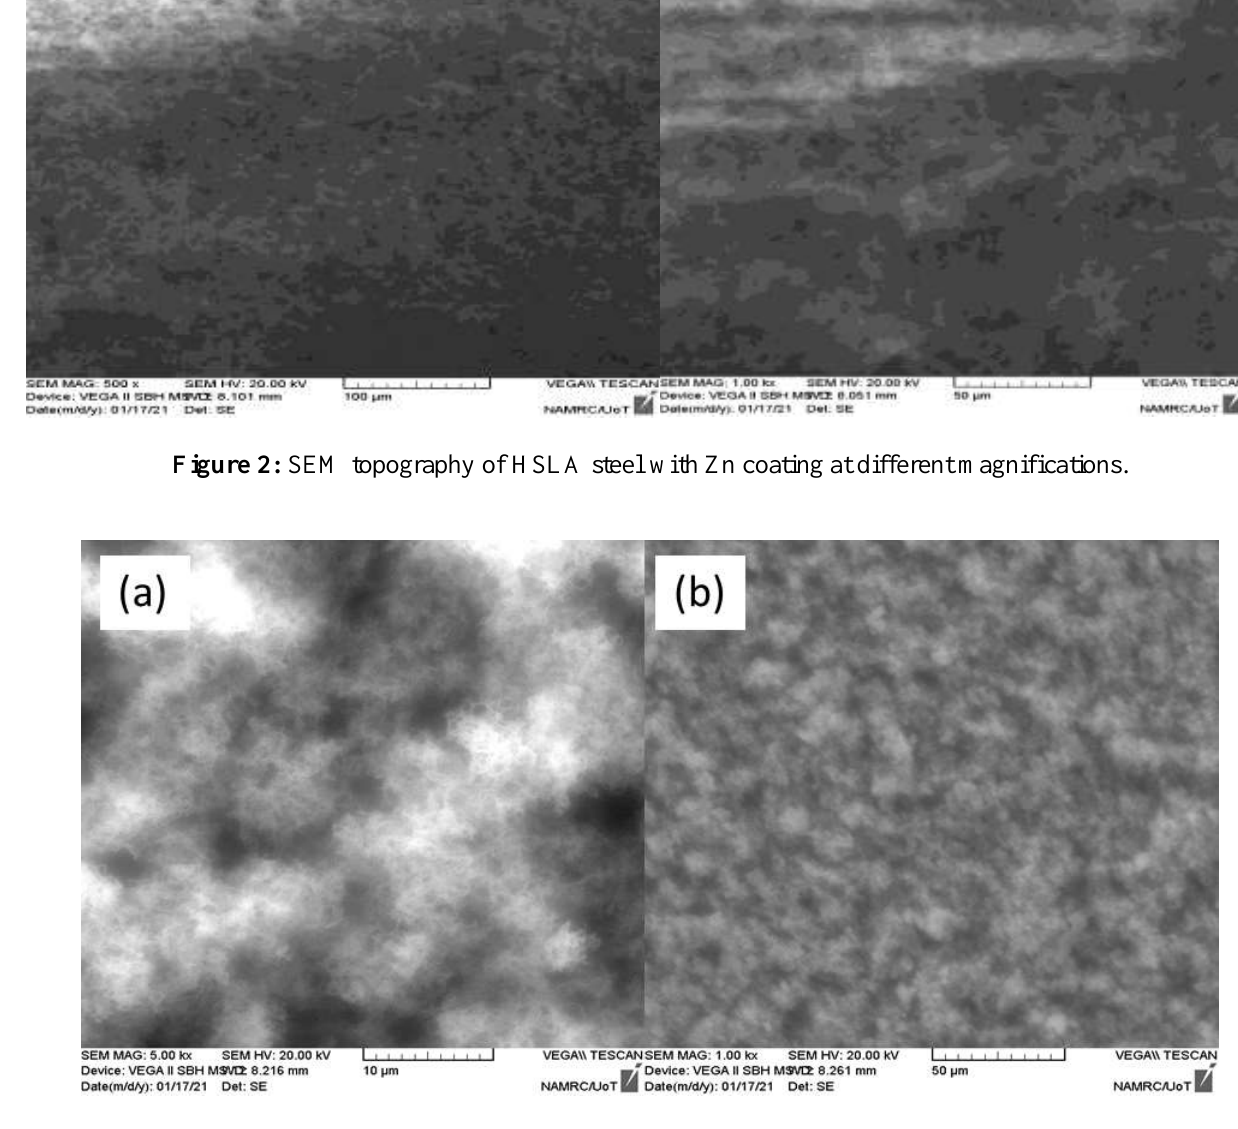
Figure 3 : SEM topography of HSLA steel nitride and Zn coated at different